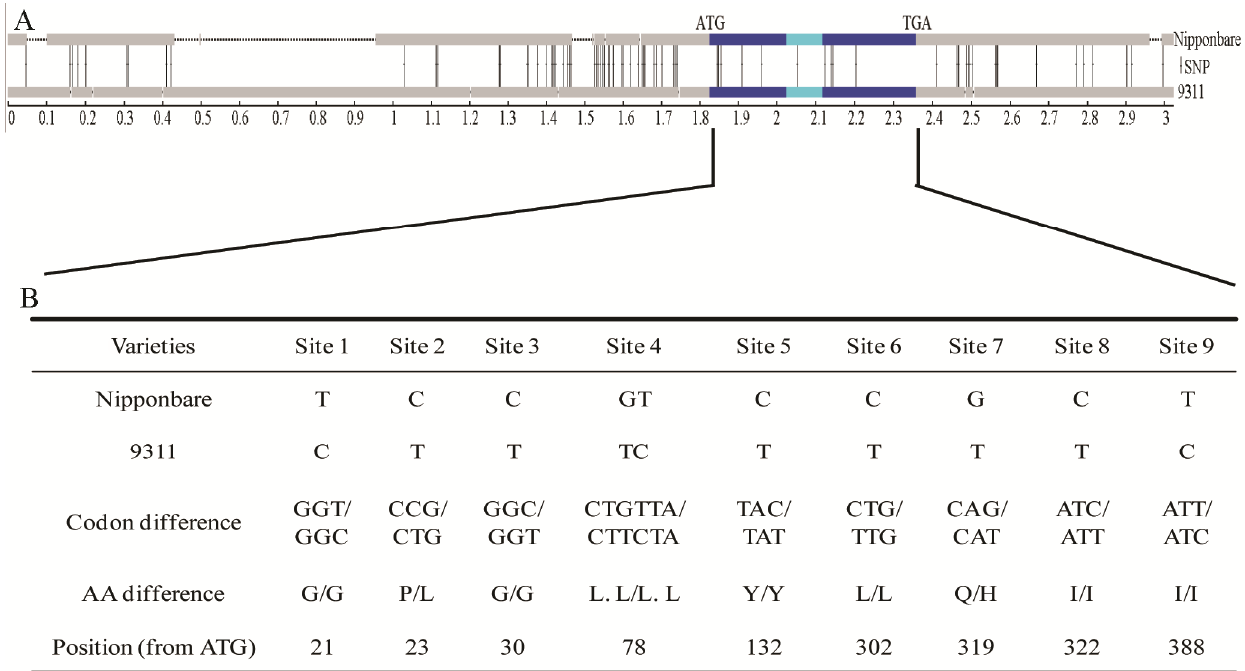
Figure 4. Schematic drawing of ISP structure with a summary of DNA and protein polymorphisms in Nipponbare ( O. sativa L. ssp. japonica ) and 9311 ( O. sativa L. ssp. indica ). ( A ) Gene model of ISP . Dark blue boxes indicate the two exons, and blue boxes represent introns and other non-coding regions. Dotted lines show the deletions. Numbering is from the left border of promoter region. SNPs are indicated by solid bars; and ( B ) Summary of the DNA and protein variations in ISP between Nipponbare and 93-11.